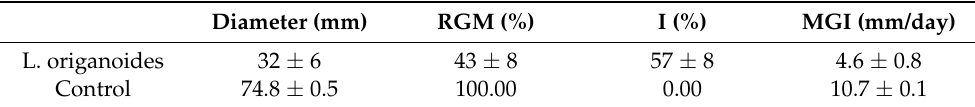
Table 8. Growth and inhibition parameters of M. perniciosa, considering the L. origanoides essential oil and the tested